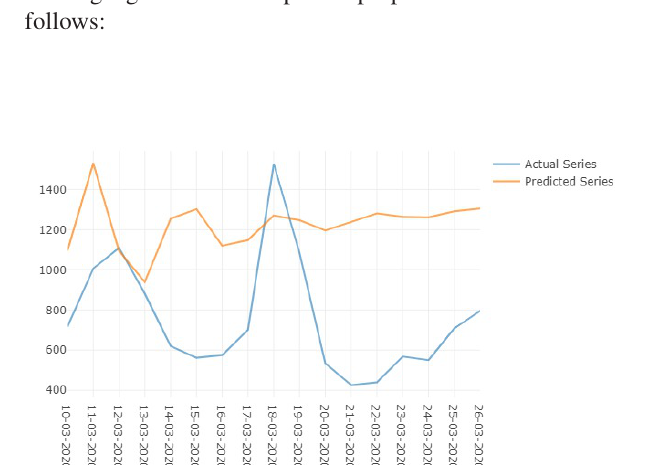
Figure 2. Forecast results for ARIMA